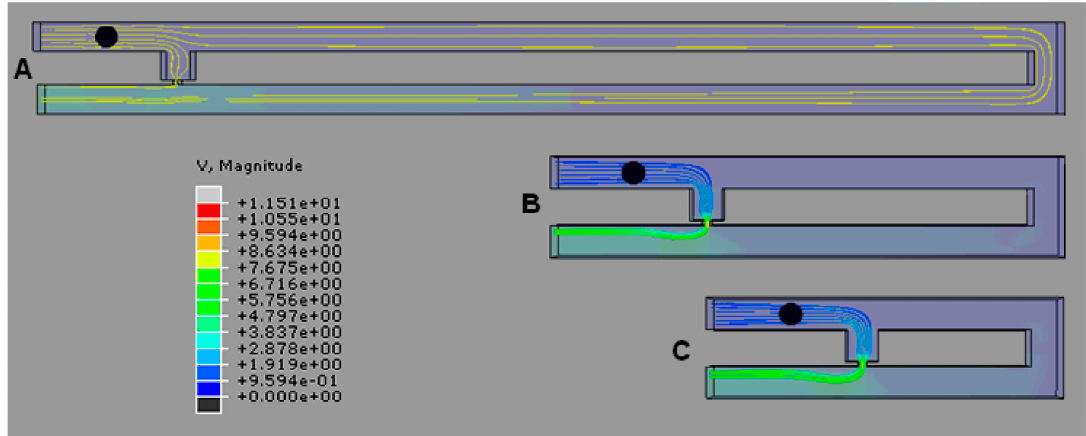
Figure 5. Velocity streamlines for the cell trapping model (top view) with Rh Main / Rh Trap ratio of 3.5 for model with trap hole width of ( A ) 1.0 μ m; ( B ) 1.5 μ m; or ( C ) 2.0 μ m. V represents the fluid’s velocity in μ ms − 1 .